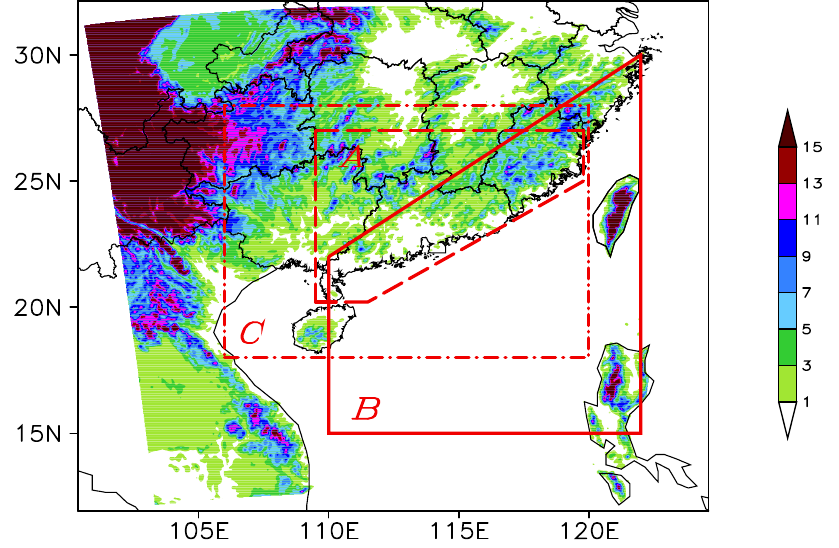
Figure 2. The model domain with shaded areas indicating topographic height (unit: 100 m). Region A shows the area where topography is removed in Exp NT; region B indicates the area where water points are replaced by grassland in Exp NLS; and region C shows the area of Figures 1a, 4, 5, 7 and